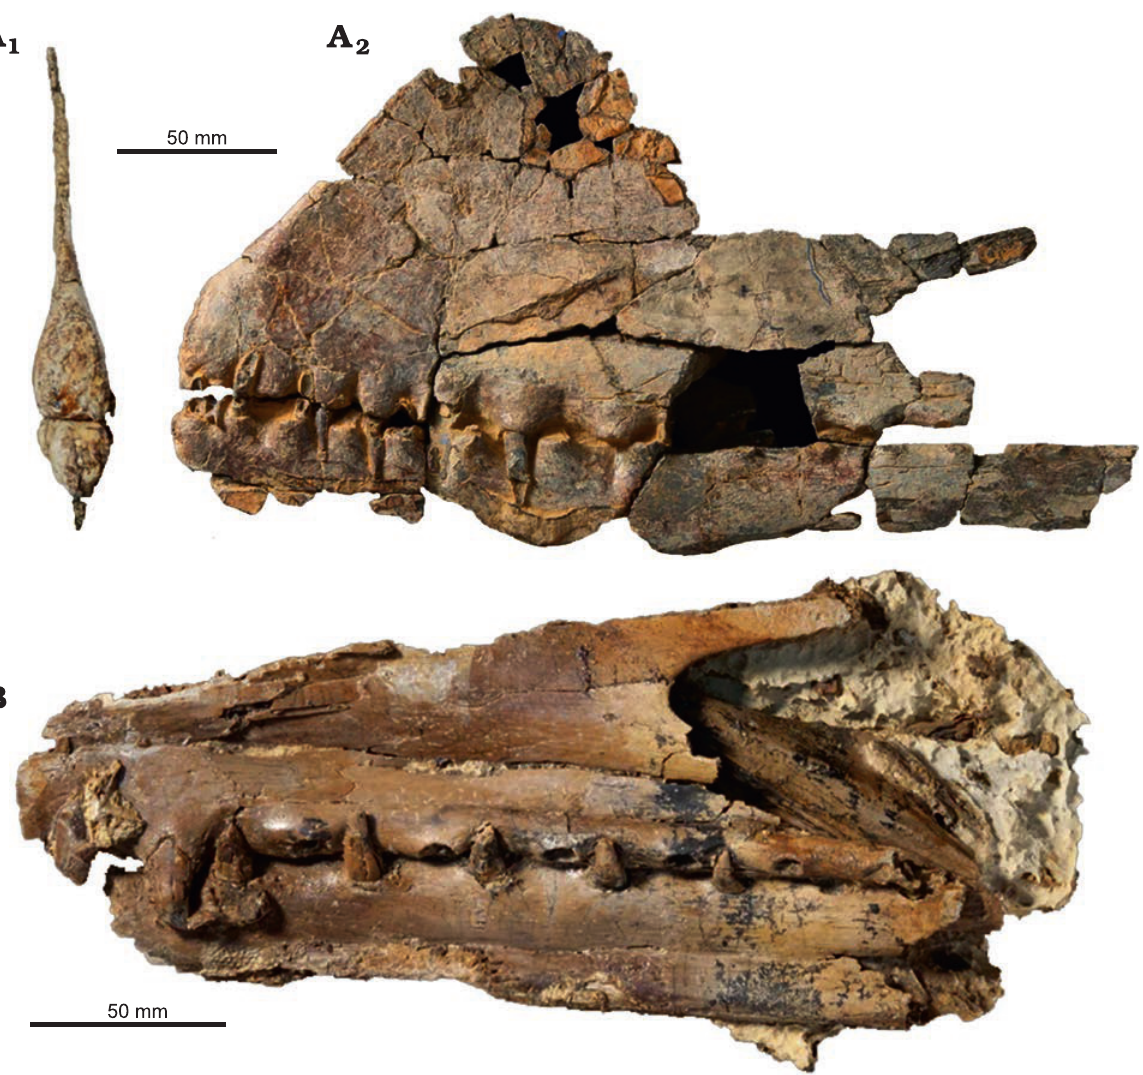
Fig. 7. Australian tropeognathine pterosaurs. A . Ferrodraco lentoni Pentland, Poropat, Tischler, Sloan, and Elliott, 2019, AODF 876, Winton, Queensland, Australia, upper Cenomanian–lower Turonian. In anterior (A 1 ) and left lateral (A 2 ) views. B . Mythunga camara Molnar and Thulborn, 2008, QM F18896, Hughenden, Queensland, Australia, Albian. In left lateral view. Pictures modified from Pentland et al. (2019) under a CC­BY 4.0